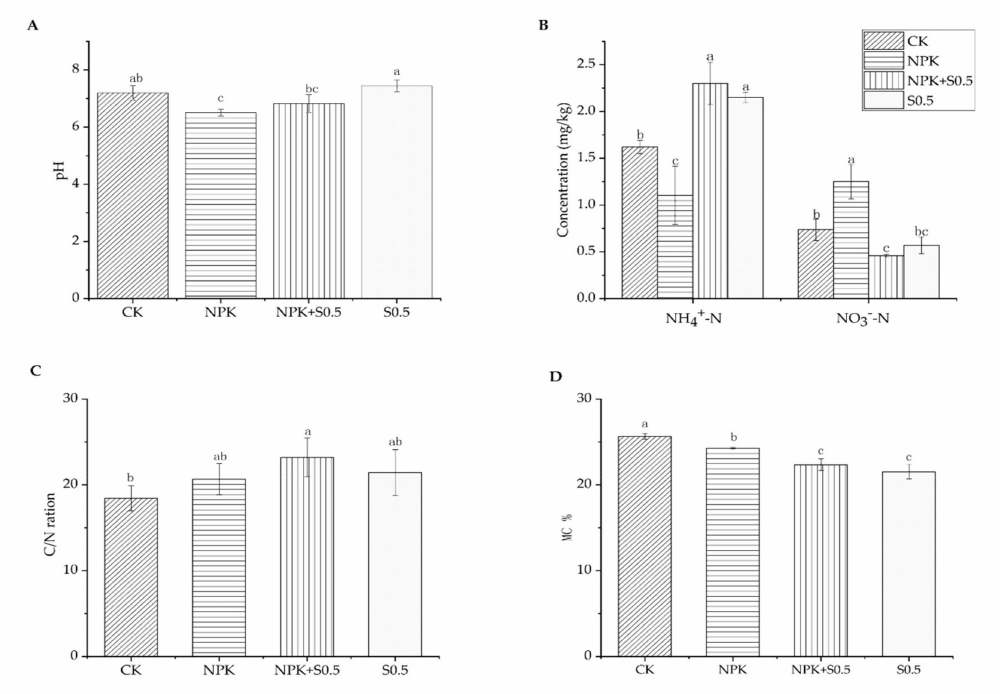
Figure 1. Soil chemical properties with di ff erent fertilizer applications. ( A ) pH changes with fertilizer application; ( B ) NH 4 + -N and NO 3 − -N changes with fertilizer application; ( C ) C / N ratio changes